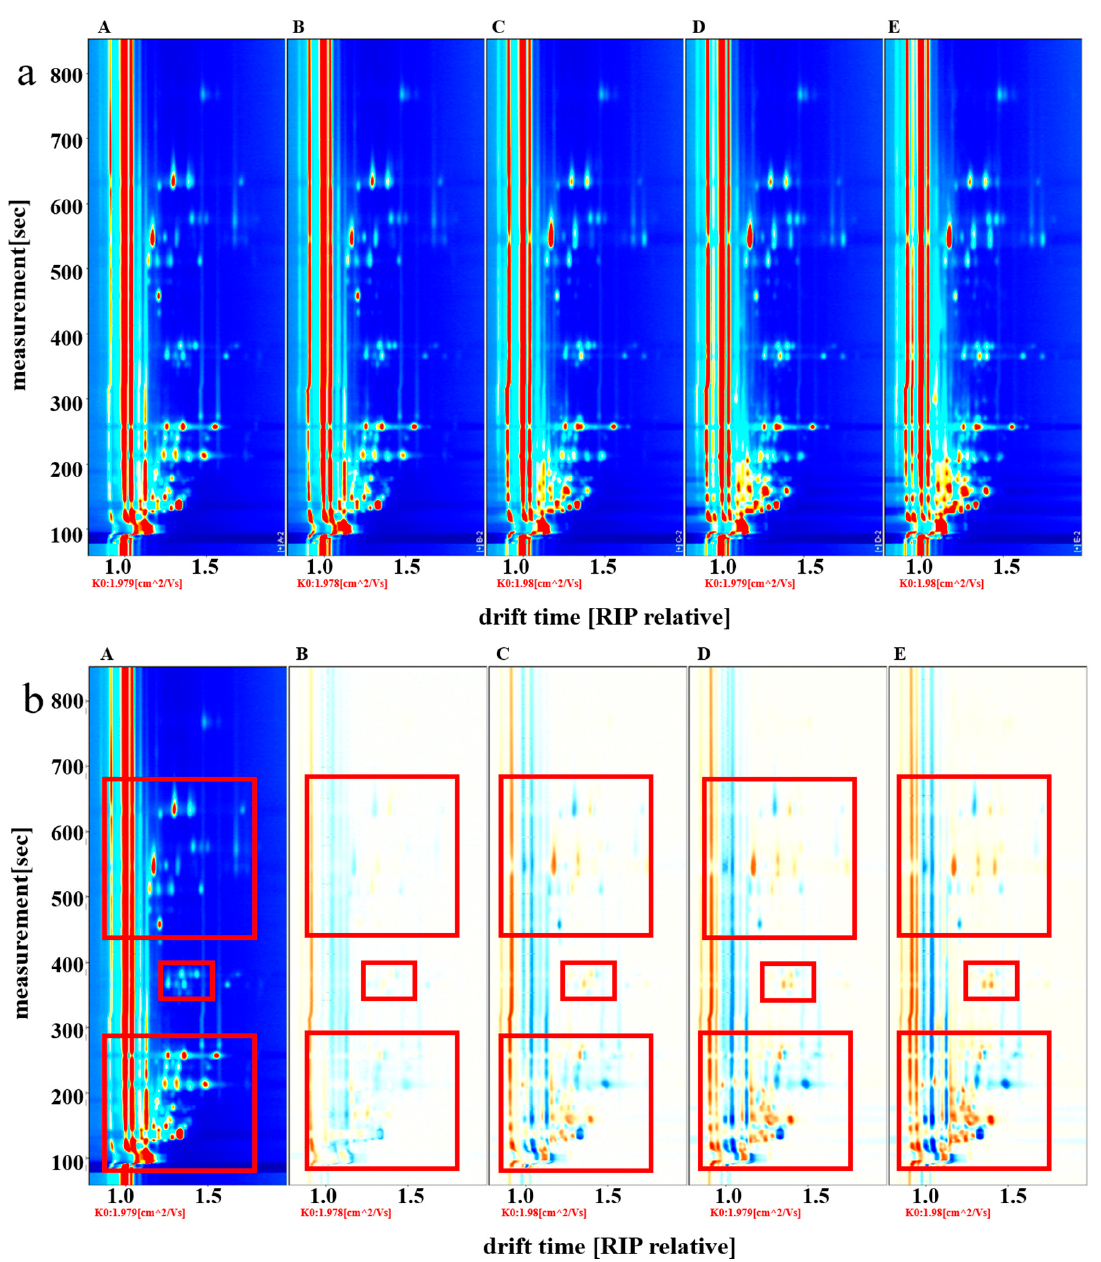
Figure 3. Two-dimensional GC-IMS spectra of volatile organic compounds in tilapia fish cakes with different processing methods. ( a ) original spectrum; ( b ) differential contrast spectrum. (A) untreated fish cake; (B) drying treatment fish cake; (C) 105 °C sterilization fish cake; (D) 115 °C sterilization fish cake; (E) 121 °C sterilization fish cake. Red boxes were the difference of volatile organic compounds among different processing methods.